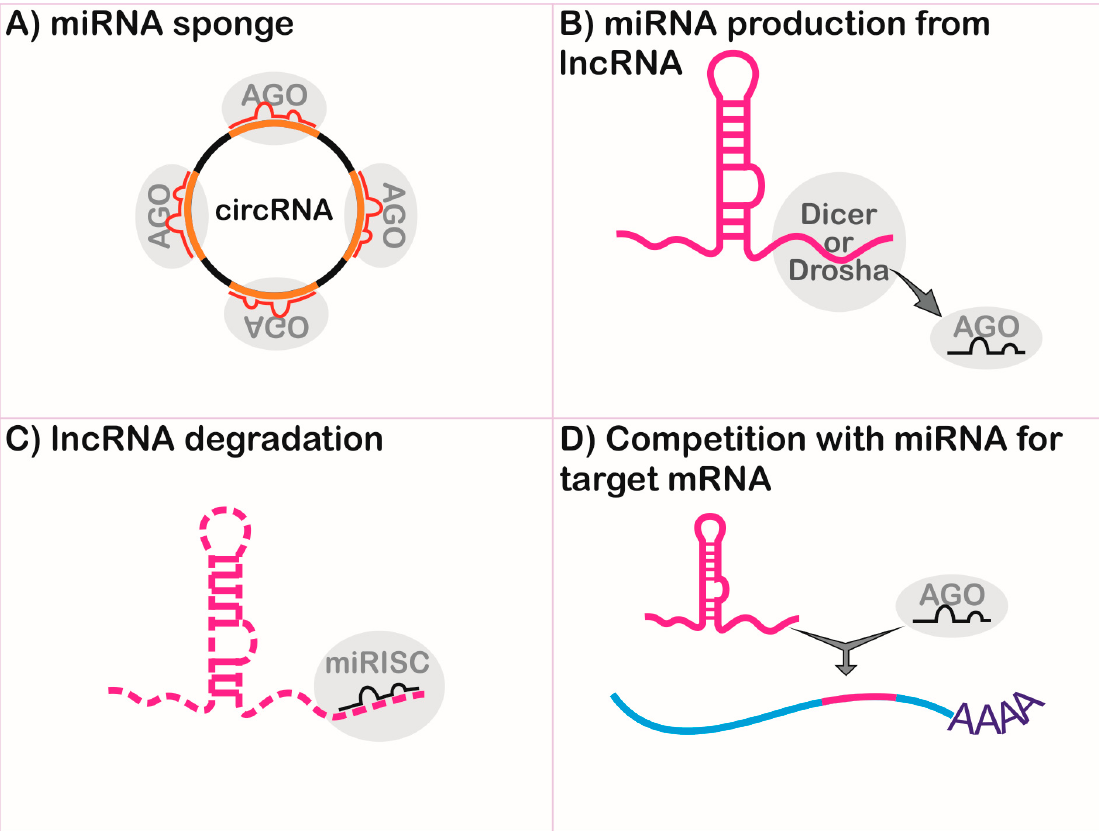
Figure 3. Interaction between microRNAs (miRNAs) and lncRNAs. ( A ) lncRNAs can act as miRNA sponges in both linear or circular forms, thus reducing interaction between miRNA-target mRNA; ( B ) lncRNA can harbor miRNA precursors, producing mature miRNAs after Dicer and/or Drosha cleavage; ( C ) miRNA can target lncRNA for degradation, similar to 3’ untranslated region binding to mRNAs; and ( D ) lncRNA–miRNA competition for the mRNA binding site. circRNA—circular lncRNA;